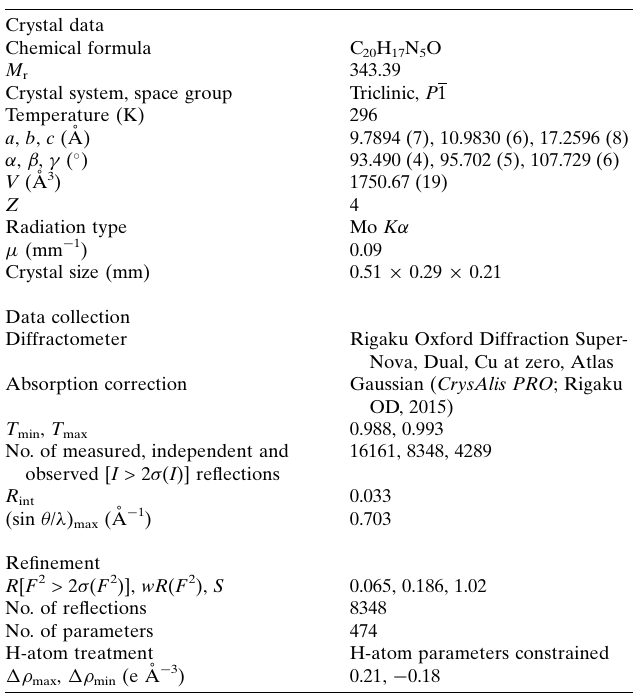
Table 2 Experimental details.